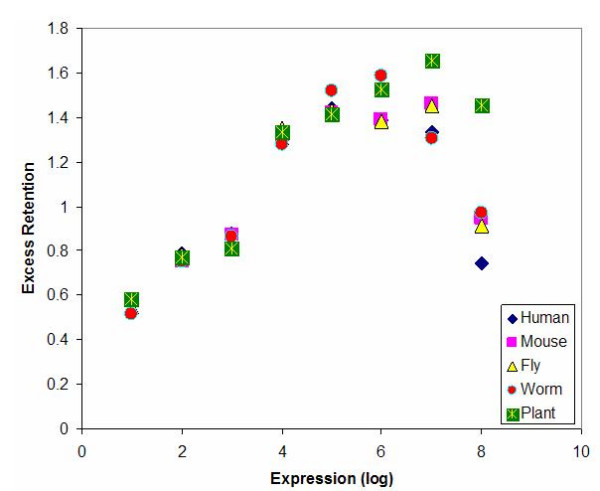
Evolutionary Excess Retention and Abundance. The relationship between the expression level of a protein and Excess Retention shows a strong correlation ρ: 0.67866. Proteins that are highly abundant in the cell tend to be older.